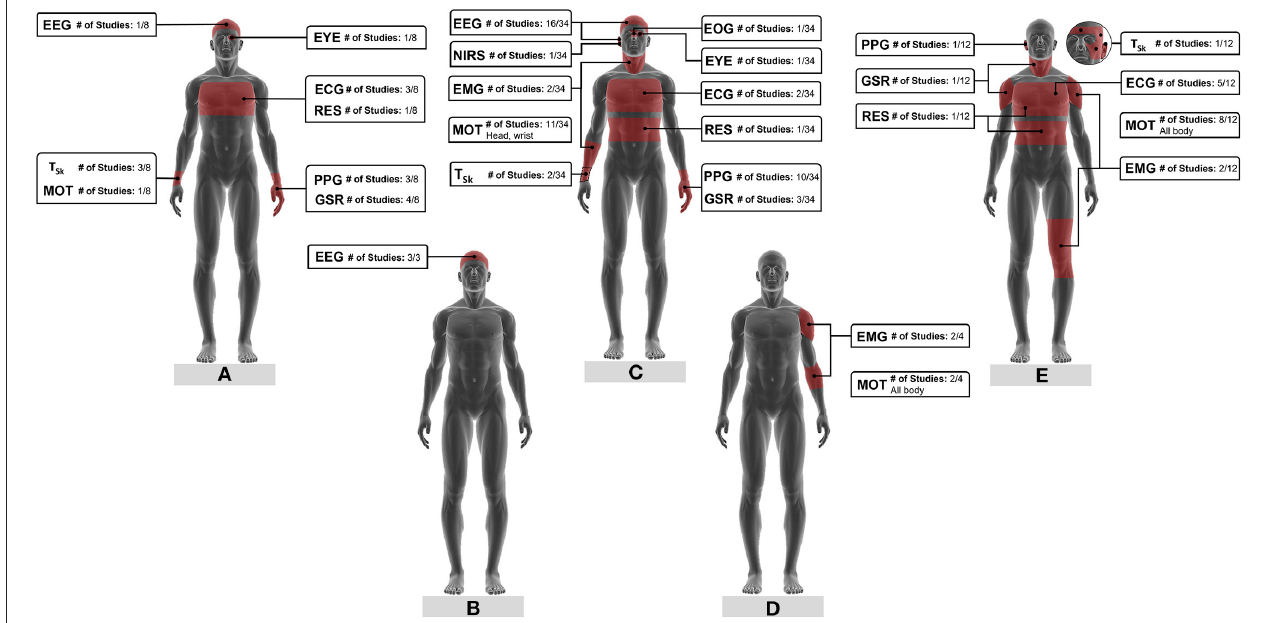
FIGURE 4 | Physiological and motion signals for (A) mental fatigue, (B) vigilance, (C) drowsiness, (D) muscle fatigue, (E) physical fatigue monitoring and respective measurement locations. The fraction number in the boxes represents the number of studies on a specific signal based on the total literature reviewed on that type of fatigue . ECG, electroencephalogram; EEG, electroencephalogram; EMG, electromyogram; EOG, electrooculogram; EYE, eye movement; GSR, galvanic skin response; MOT, motion; NIRS, near-infra-red spectroscopy; PPG, photoplethysmogram; RES, respiration; T Sk , skin